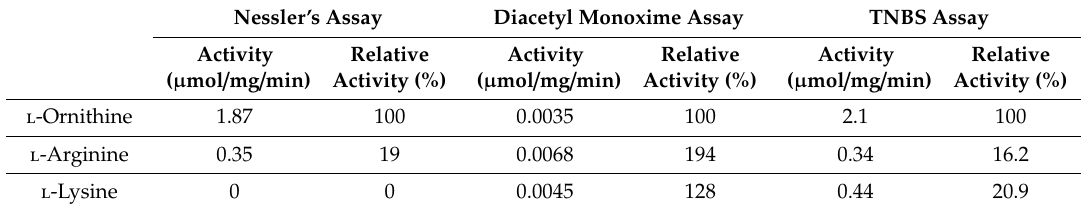
Table 3. Substrate specificity of the purified ODC of A.